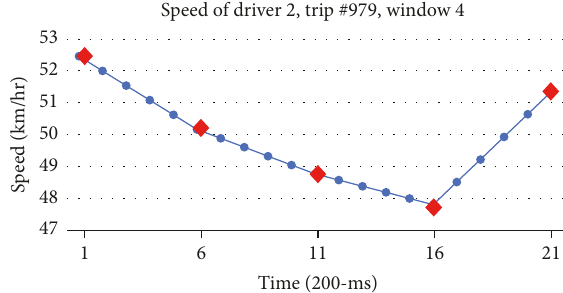
Figure 5: The red diamond dots show the original speed infor- mation, each 1 second apart. The line graph shows result of linear interpolation between each original